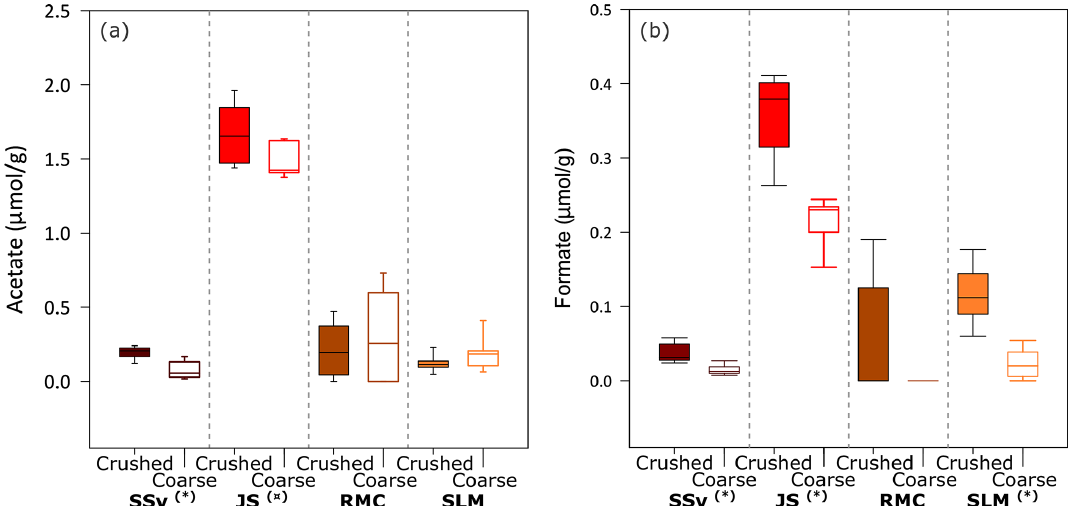
Figure 4. Concentration of acetate and formate in solution from incubation of crushed and coarse rock and sediment samples with ultrapure water at all time points (5min, 5h and 25h). Boxplots of (a) acetate concentration in solution (normalised to µmol acetate g − 1 ) and (b) for- mate concentration in solution (normalised to µmol formate g − 1 ) after the incubation of coarse and crushed samples ( n = 9 for each sample type). Highly significant difference ( p ≤ 0.01) between crushed and coarse samples is denoted by ( ∗ ). Significant difference ( p ≤ 0.05) be- tween crushed and coarse samples is denoted by ( ). The minimum and maximum values are represented by the whiskers, the interquartile range is represented by the box, and the median value is shown by the line in the centre of the